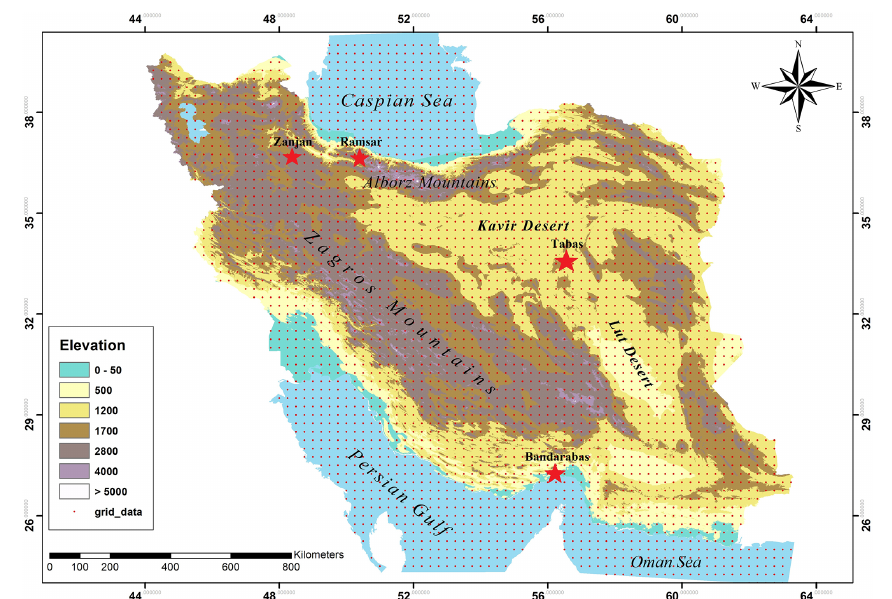
Figure 1. A map of Iran illustrating the geographical topography and the domain of the grid points used in the model simulation. Red stars indicate the selected stations for uncertainty